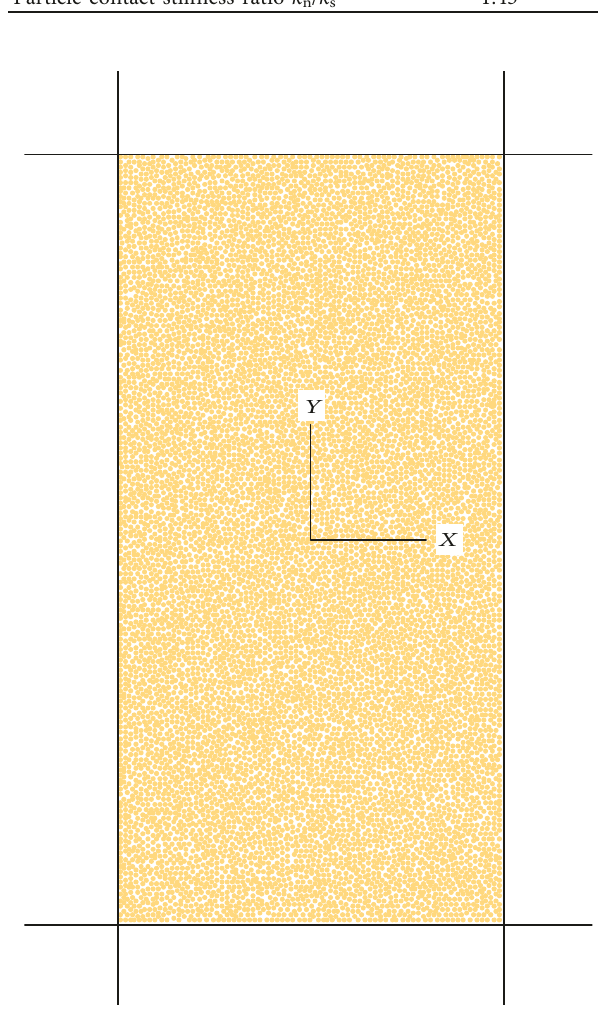
Figure 1: Granular aggregate.